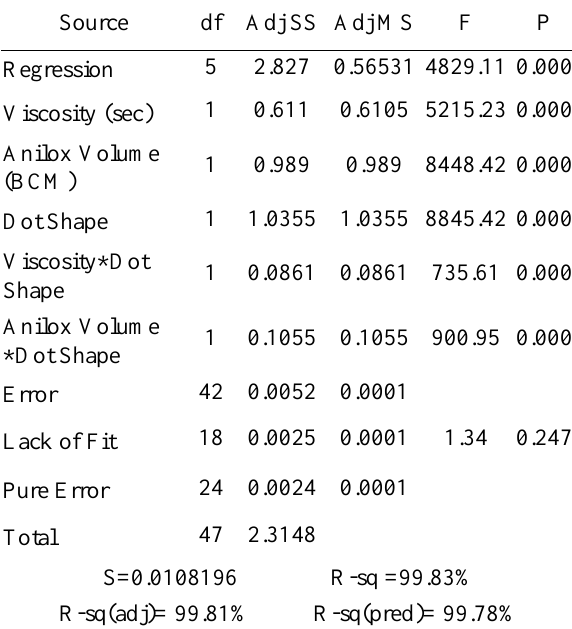
Figure 13. Interaction plot for print mottle Table 8. ANOVA for print